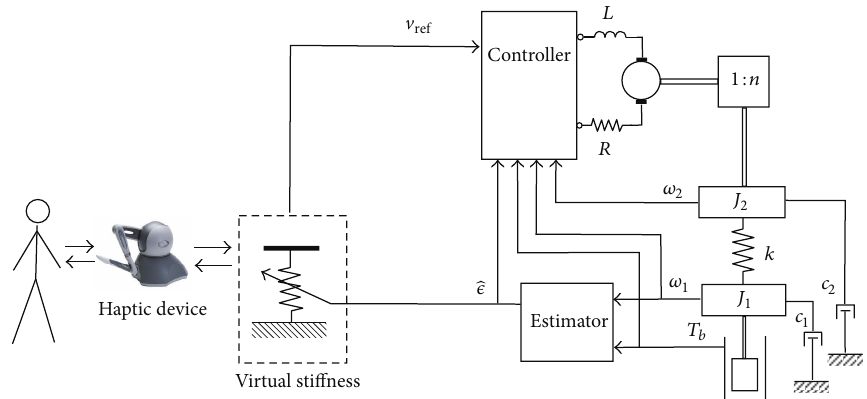
Figure 15: The structure of a telerobotic drilling